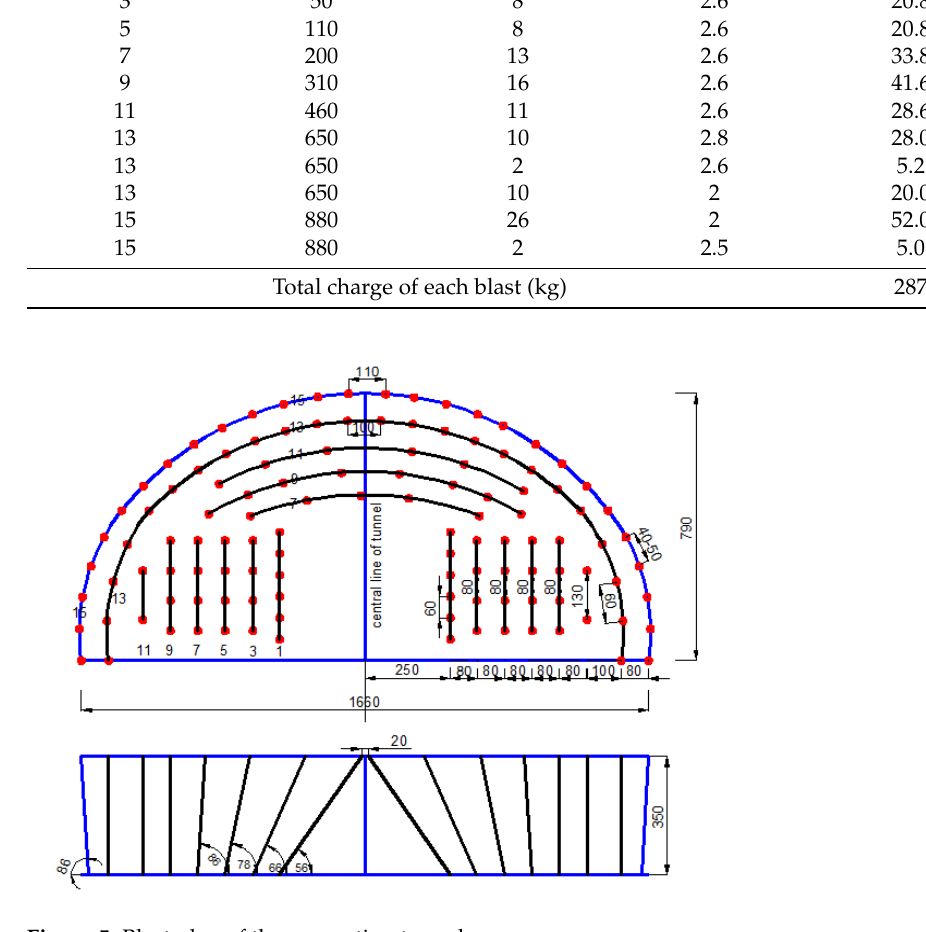
Figure 5. Blast plan of the excavating tunnel.